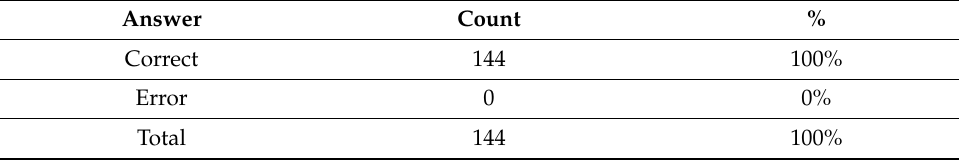
Table 2. Validity of OCI at Grade 0.